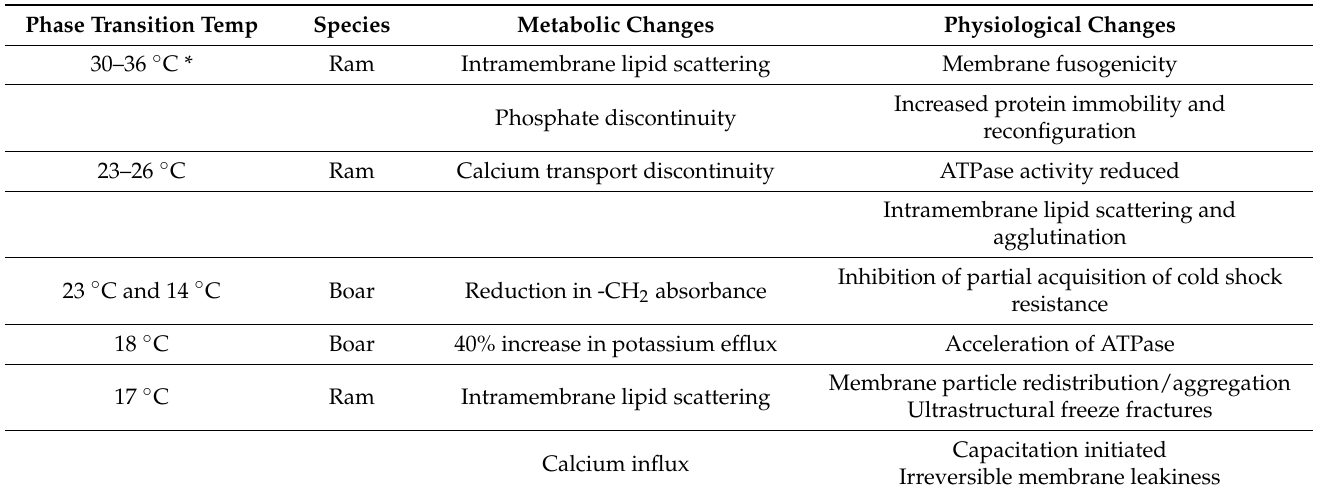
Figure 2. Summary of significant structural, functional, and molecular impairments incurred by ram spermatozoa cells undergoing osmotic and thermal stress inflicted by storing indefinitely via cryopreservation or temporarily chilled to 5–15 °C. Adapted from [1,4] and created on BioRender.com. Table 3. Significant thermotropic phases and associated metabolic and physiological effects in the ram and boar spermatozoa .